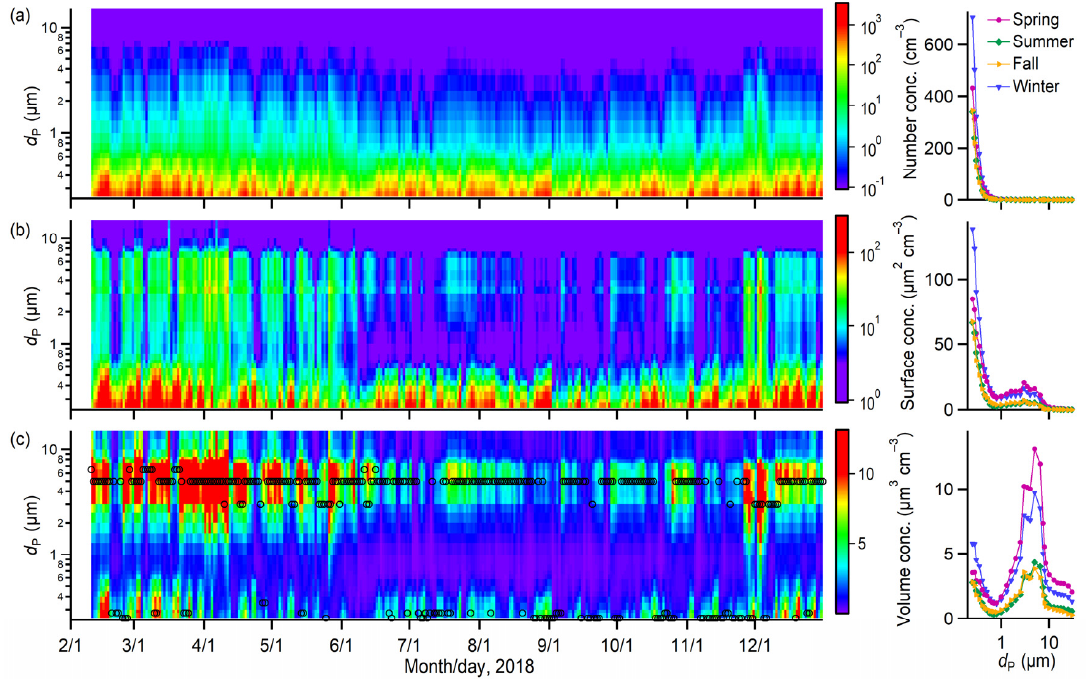
Figure 4. Size-resolved ( a ) number, ( b ) surface area, and ( c ) volume concentrations of PM over the studied period and their seasonally averaged size distributions. Results presented in the image plots were averaged for daily data. The black circles in ( c ) represent the mode diameters of PM volume concentrations.